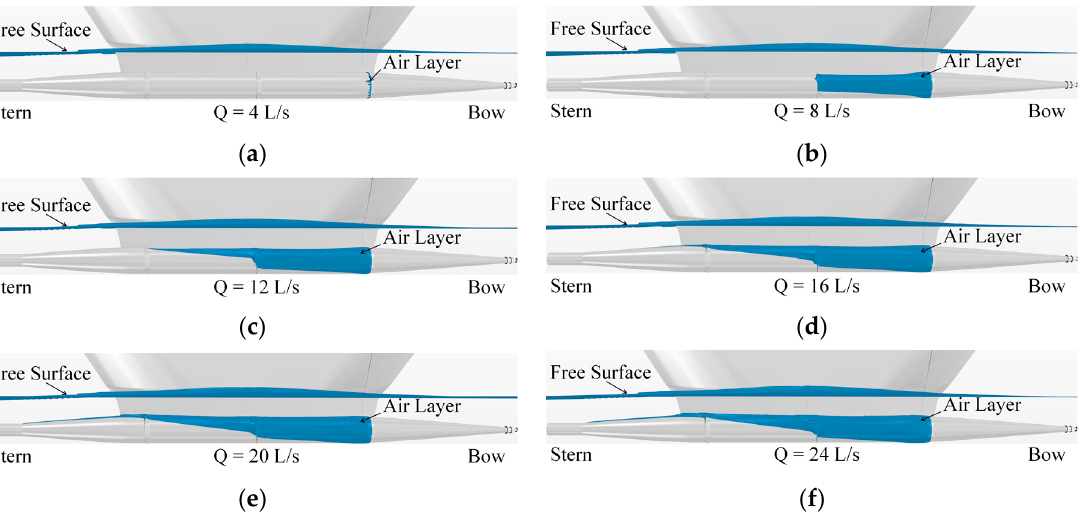
Figure 8. Air layer distribution with air injected from location L2: ( a ) Airflow rate Q = 4 L/s; ( b ) Airflow rate Q = 8 L/s; ( c ) Airflow rate Q = 12 L/s; ( d ) Airflow rate Q = 16 L/s; ( e ) Airflow rate Q = 20 L/s; ( f ) Airflow rate Q = 24 L/s.